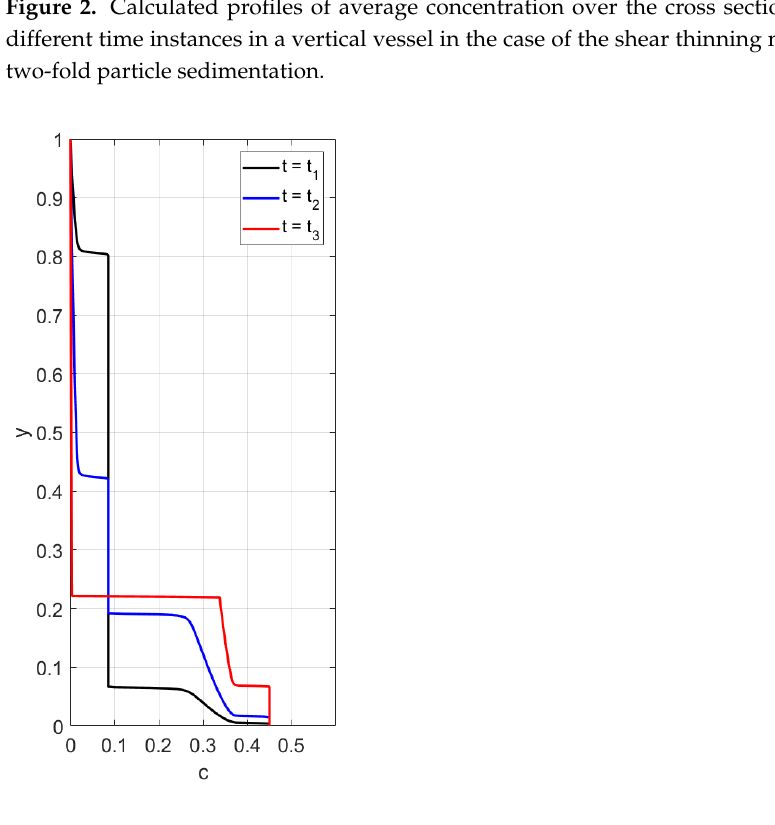
Figure 3. Calculated profiles of the concentration wave at different time instances for the shear thinning flux F sh ( c ) in the case when all the dissipation effects are negligible. The initial and boundary data are c 0 = 0.09, c bot = 1, c top =